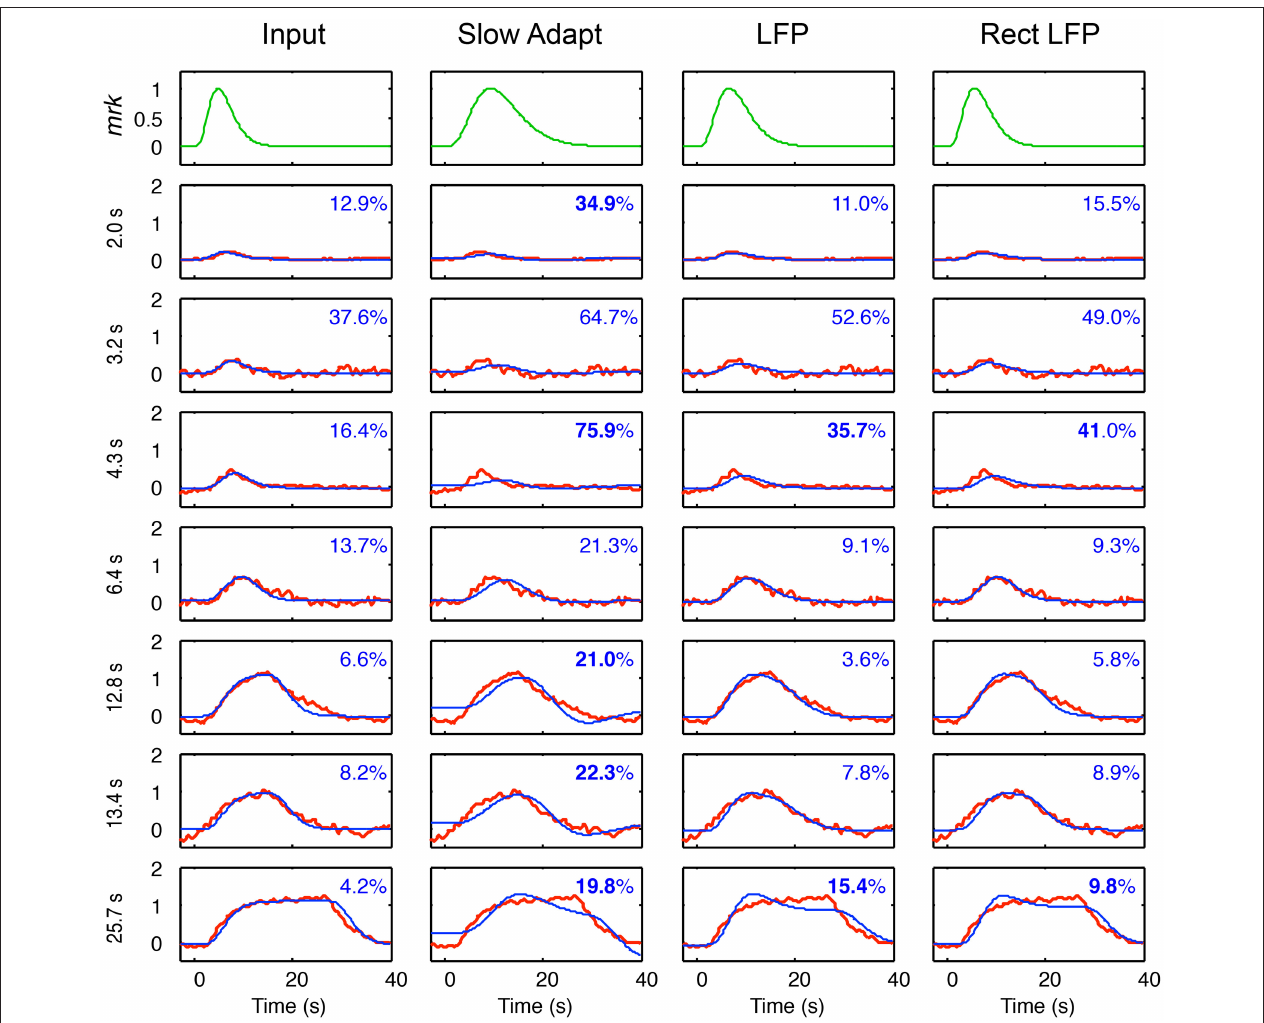
FIGURE 7 | Model fits (blue curves) for the four models of BOLD coupling for the respective components of the LFP coupling models of Figure 6 fitted to the average BOLD responses (red curves) at 7 durations. Top row shows the BOLD metabolic kernels (green curves) required to best fit for each model. Insets specify the percent residual variance of the fits, with those significantly higher than those for the Input model shown in bold. The non-adapting neural Input model thus provides the best fit to the average BOLD data